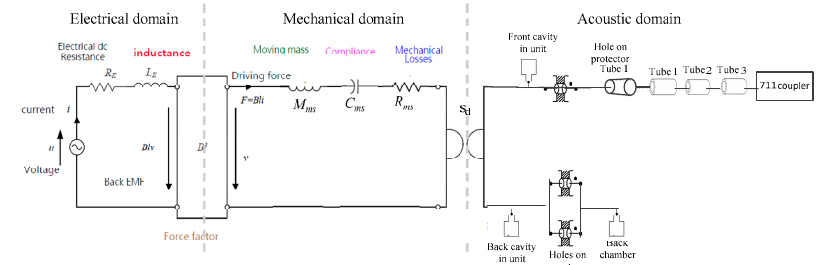
Figure 12. Coupling between mechanical and acoustic domains.